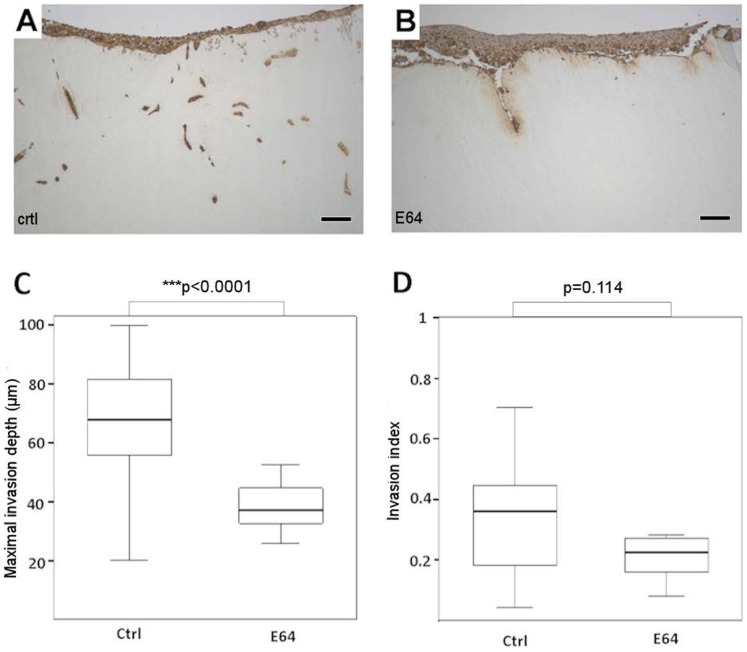
Cathepsin inhibitor E64 reduces HSC-3 tongue carcinoma cell invasion in the myoma organotypic invasion model.The effect of cathepsin inhibitor on the invasion of HSC-3 cells in the myoma organotypic assay was studied. E64 at 10 µM could prevent HSC-3 invasion as compared with the controls (A–B). Overall HSC-3 cell invasion depth (C) as well as invasion index (the ratio between the invaded area and the total area of AE1/AE3-stained HSC-3 cells) (D) were quantified. The invasion depth was significantly reduced (***p<0.0001), but the invasion index shows no significant reduction (p = 0.114). Scale bars 200 µm.